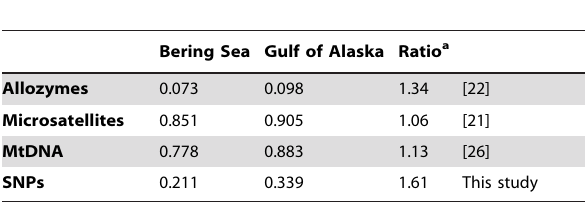
Table 5. Unbiased heterozygosity of four genetic markers from Pacific herring; haplotype diversity was used for